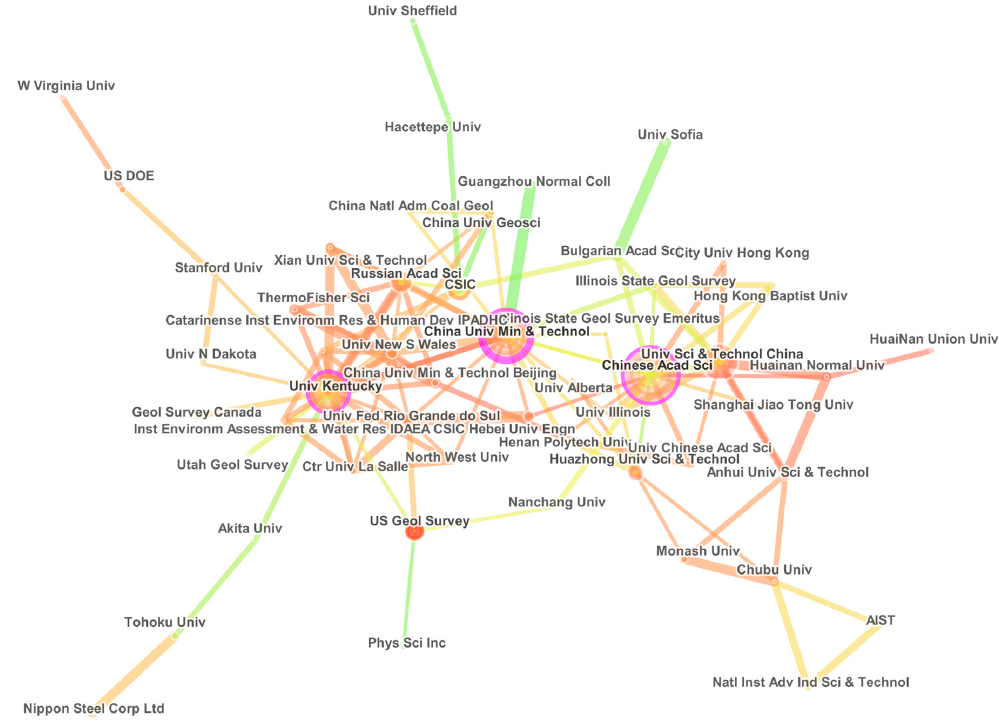
Figure 4. The total publications of the most productive institutions of trace elements in coal and ash.